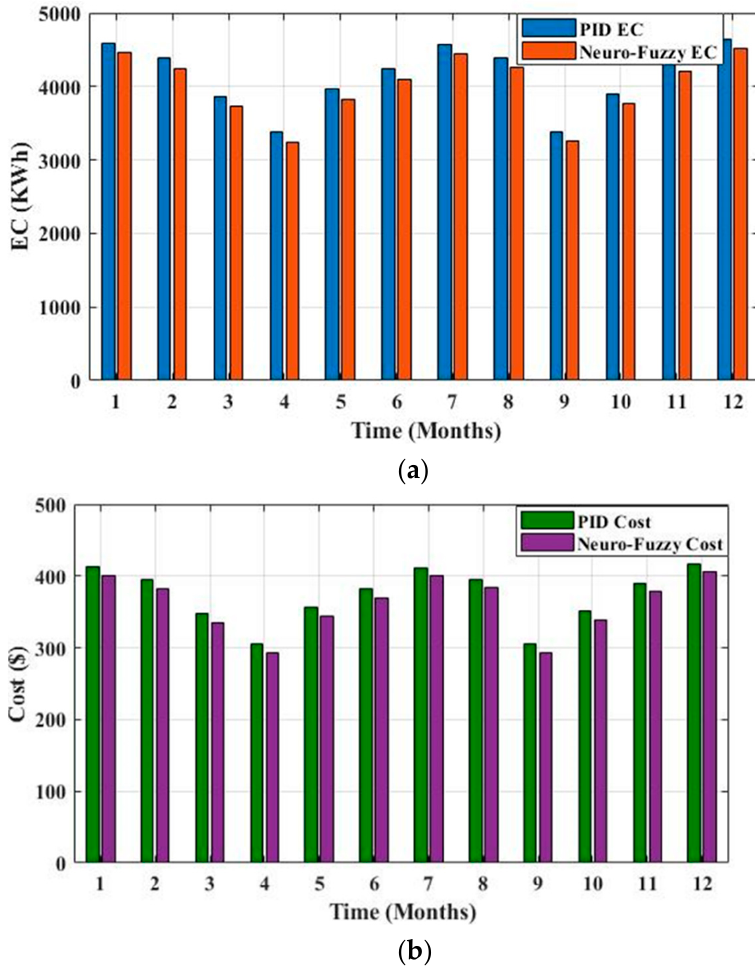
Figure 12. ( a ) EC and ( b ) energy cost of PID and adaptive NF-II control system.